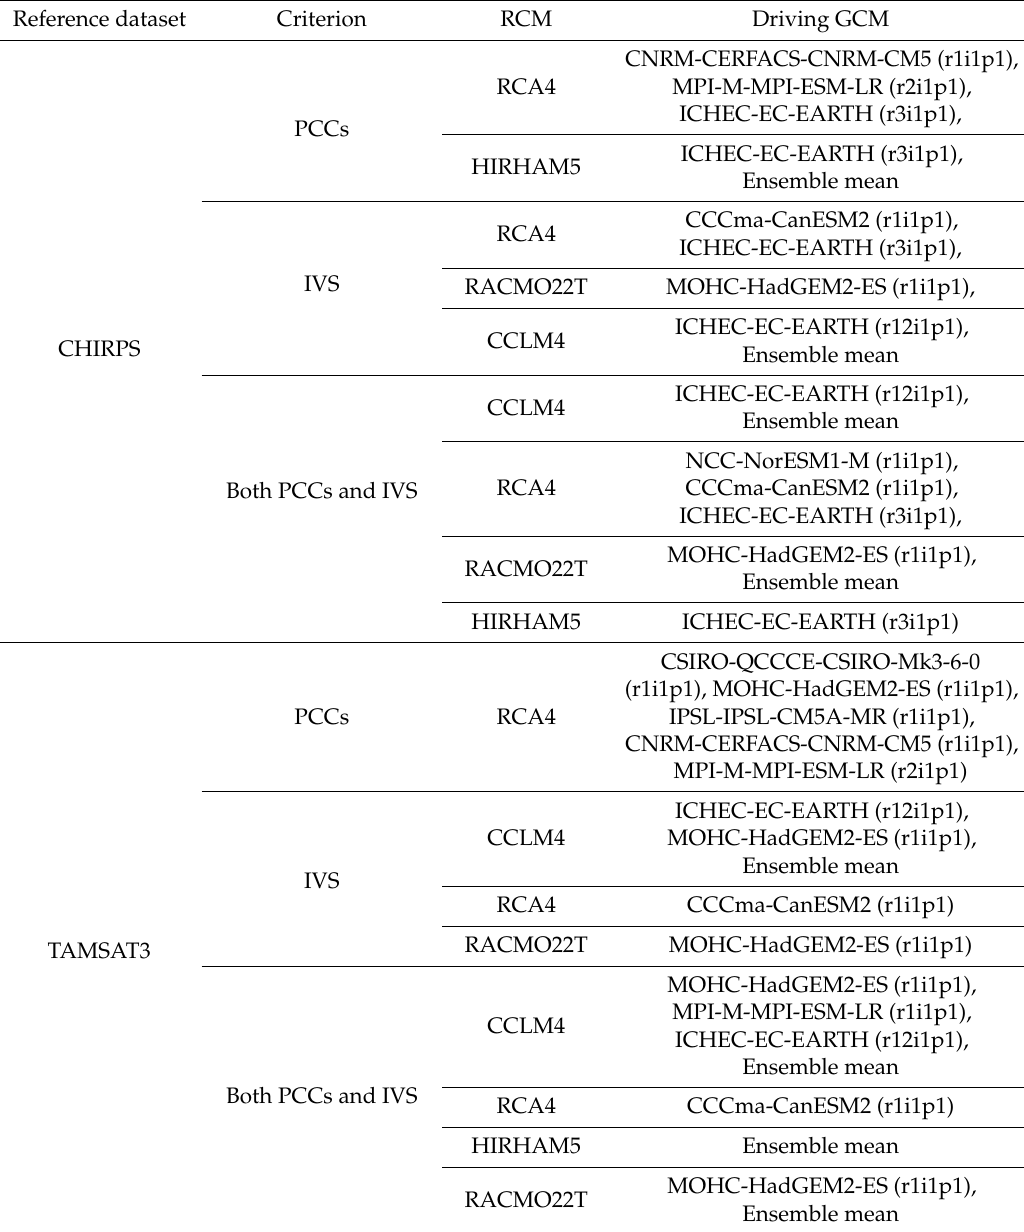
Table 5. As in Table 3 but combining the performance of model runs at both WA-N and